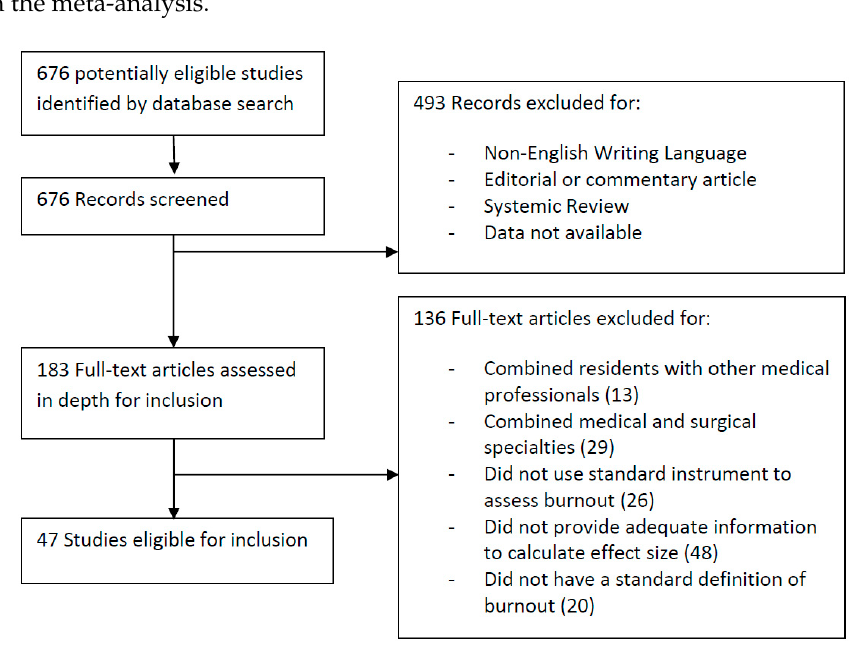
Figure 1. Study selection process.